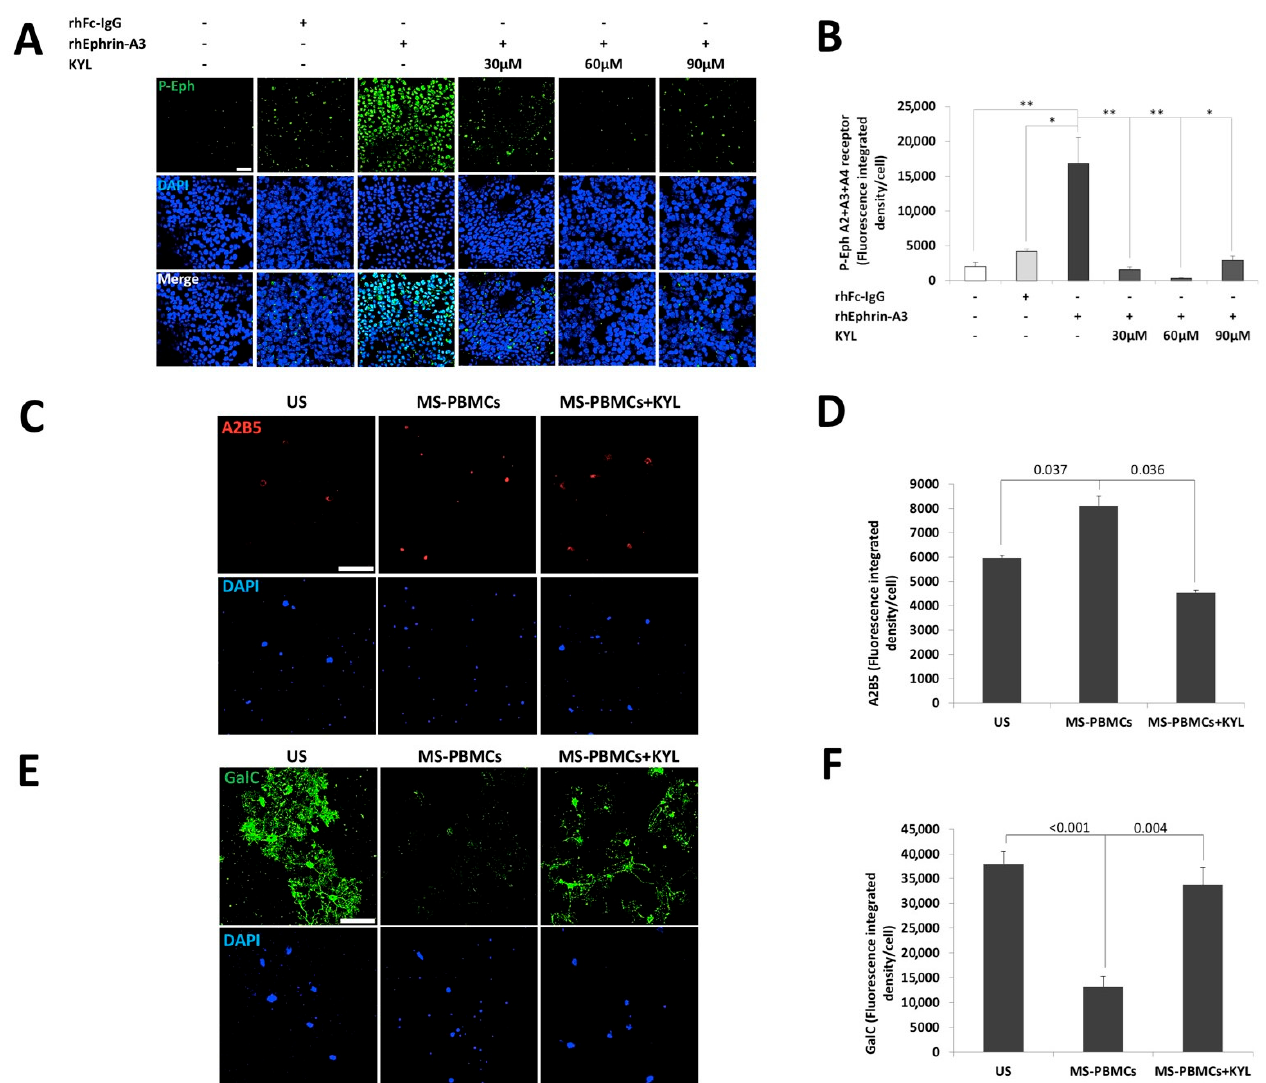
Figure 4. Immune cells of a patient with RR-MS inhibited the differentiation of oligodendrocytes precursor cells to maturing oligodendrocytes. ( A ) Representative confocal microscopy images of HEK-293T cells unstimulated or stimulated with 0.5 µ g/mL of recombinant human Fc-IgG negative control (hrFc IgG), or 0.5 µ g/mL human recombinant ephrin-A3 (hrEphrin-A3) protein, and pre-incubated with or without 30 µ M, 60 µ M or 90 µ M Eph-receptor inhibitor KYL peptide (KYL) Scheme 20. scale = 50 µ m. ( B ) Average of Eph-receptor phosphorylation analysis shown in A. * p < 0.05, ** p < 0.01. OPCs were unstimulated or co-cultured with PBMCs of patients with RR-MS with or without a pre-incubation with 60 µ M inhibitor KYL peptide in oligodendrocyte differentiation medium for 4 days. ( C ) Representative confocal microscopy images of OPCs cells immunostained by anti- A2B5 and DAPI nuclear staining after 4 days of differentiation. Magnification ×25; scale = 50 µm. ( D ) Average of A2B5 expression level analysis. (E) Representative confocal microscopy images of OPCs immunostained by GalC and DAPI nuclear staining after 4 days of differentiation. Magnification ×25; scale = 50 µm. (F) Average of the GalC expression levels analysis shown in D.